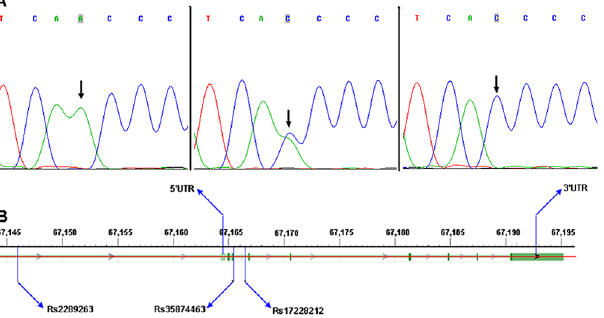
Fig 1. Schematic diagrams and DNA sequence chromatograms. A: Schematic diagrams of rs2289263, rs35874463 and rs17228212 locations in the SMAD3 gene; B: Three genotypes of DNA sequence chromatograms of